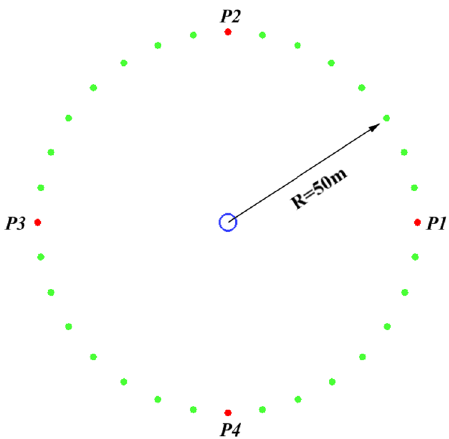
Figure 20. An illustration of the monitoring point distribution.